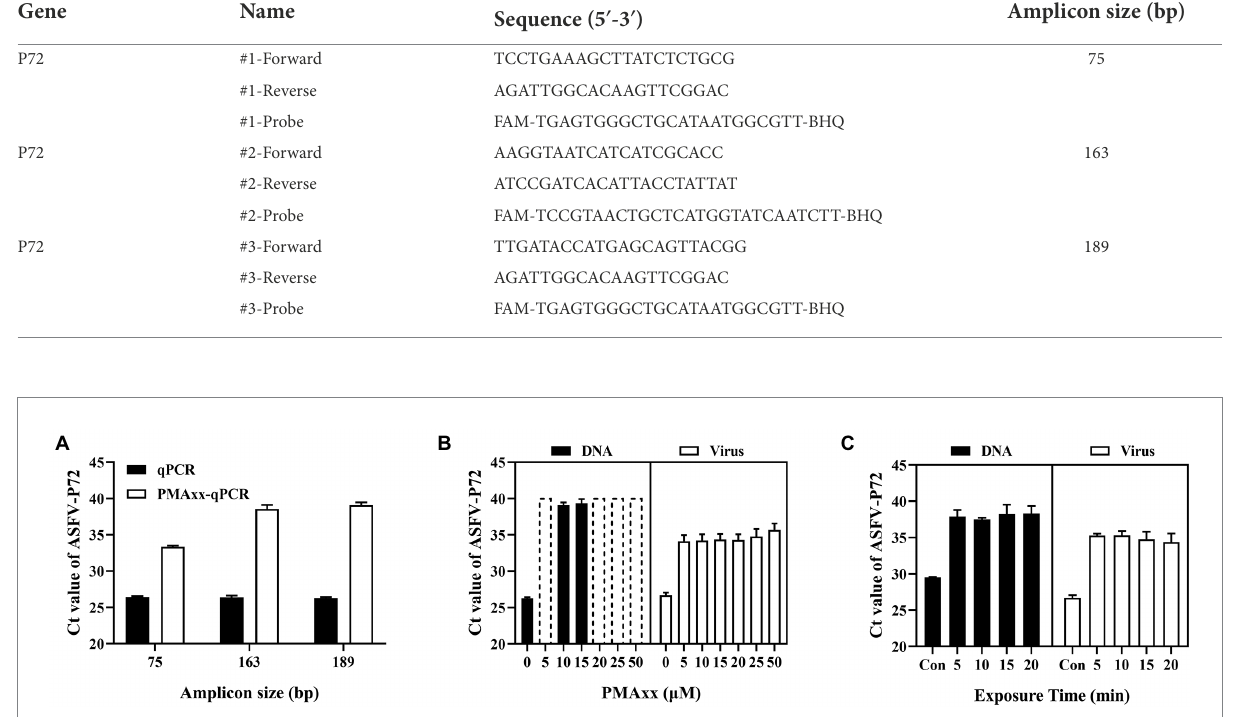
FIGURE 2 Optimization conditions of the PMAxx-qPCR assay targeting the ASFV-P72 gene for discriminating inactivated ASFV and free DNA. (A) Effects of different amplicon sizes on Ct values of free ASFV DNA (samples treated with 10 μ M PMAxx and 15 min photolysis time). (B) Effects of different PMAxx concentrations on Ct values of free ASFV DNA and ASFV in 100 times PBS-diluted swine plasma inactivated at 95 ° C for 20 min (each concentration was exposed to a photolysis time of 15 min). (C) Effects of photolysis time on Ct of free ASFV DNA and ASFV in 100 times PBS-diluted swine plasma inactivated at 95 ° Cfor 20 min (each sample was treated with a PMAxx concentration of 25 μ M). Data were shown as mean ± SD of three independent repeats. Dotted plots represent no amplification after 40 cycles and the Ct is assigned to 40 in order to calculate Δ Ct.